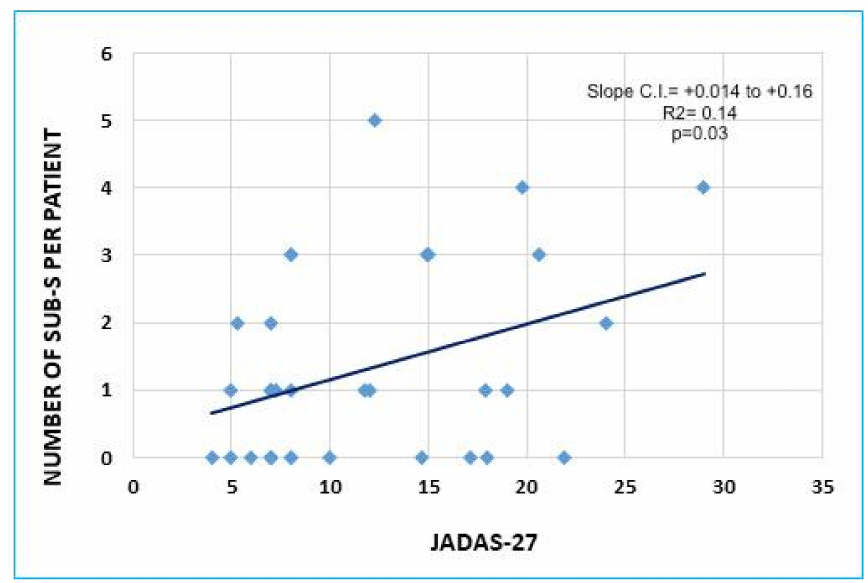
Figure 2. Graphic representation of the linear association between the number of subclinical syn- ovitis (Sub-S: CE − /US+) per patient and JADAS-27 in the active group ( p = 0.03, R2 = 0.14). C.I., confidence